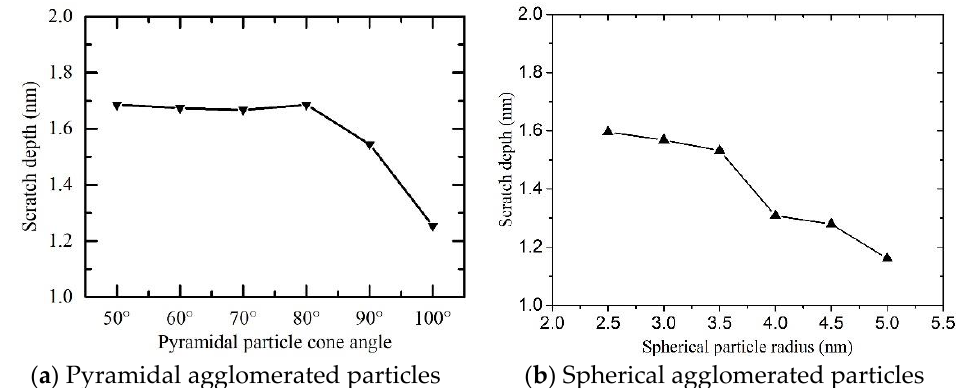
Figure 10. The actual scratch depth with different shapes and sizes of agglomerated particles.